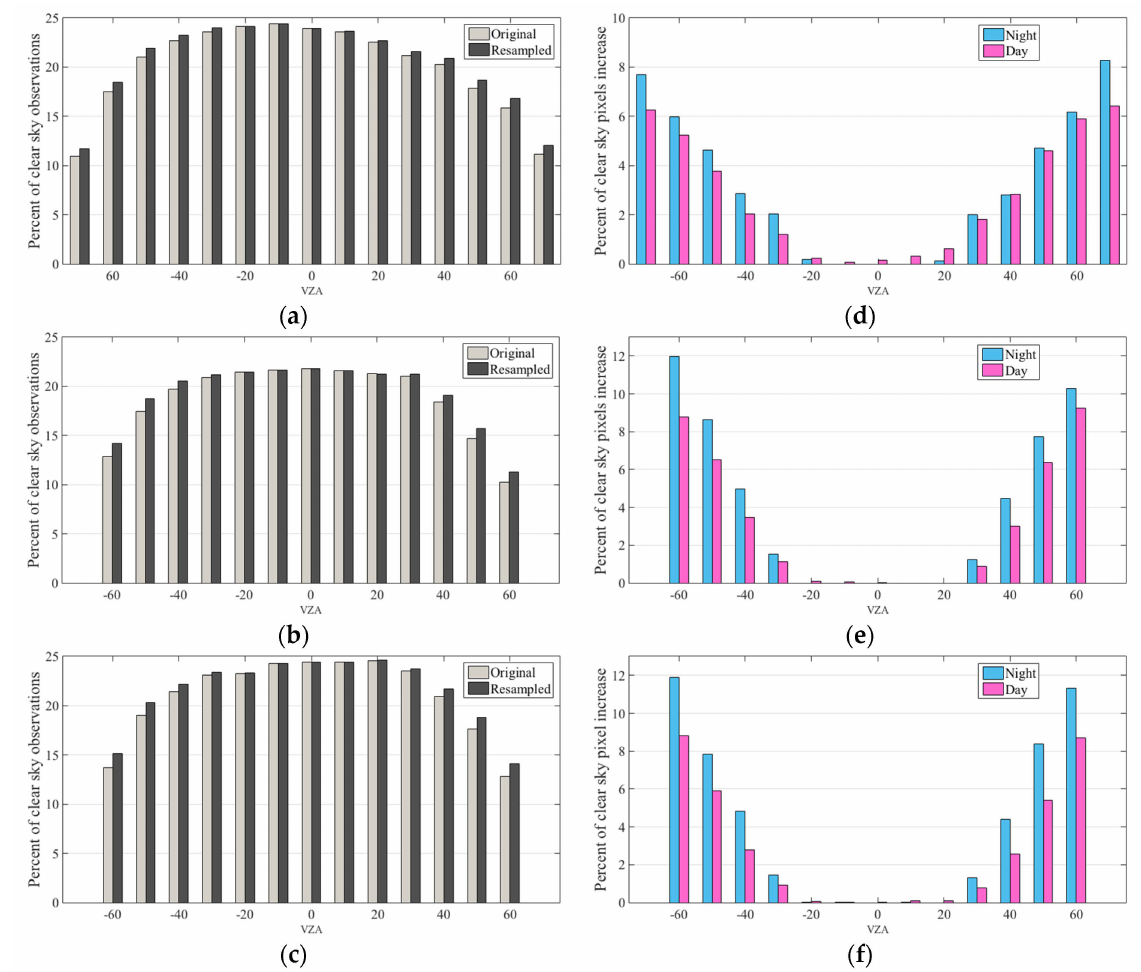
Figure 13. Number of clear sky observations for one day (18 October 2015) of global ACSPO SST data as a function of view zenith angle (VZA) for ( a ) S-NPP VIIRS; ( b ) Aqua MODIS; ( c ) Terra MODIS. Original data are shown in light gray and resampled in dark gray. Day and night data are combined together. Corresponding percent increase for ( d ) S-NPP VIIRS; ( e ) Aqua MODIS and ( f ) Terra MODIS (separated by night and